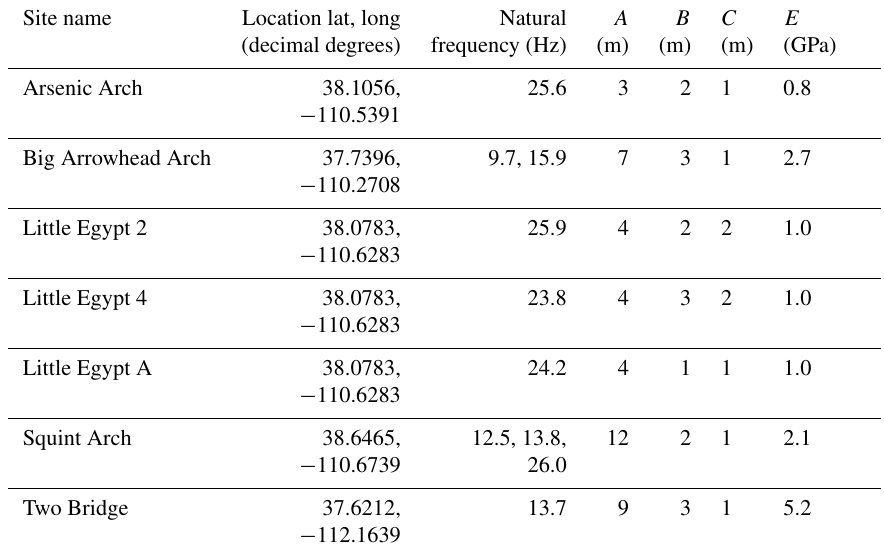
Table 1. Study site characteristics, including location, natural frequencies of interest, dimensions, and Young’s modulus of the rock mass ( E ). Dimension A is the longest or tallest axis of each landform, B is the second largest, and C is the smallest. Note these axes are roughly mutually perpendicular.